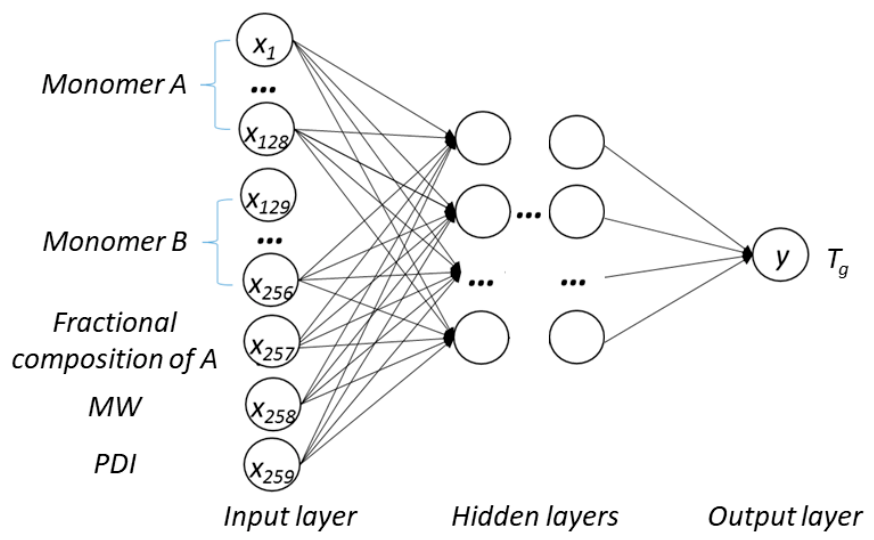
Figure 2. Illustration of the deep neural network (DNN) model structure.